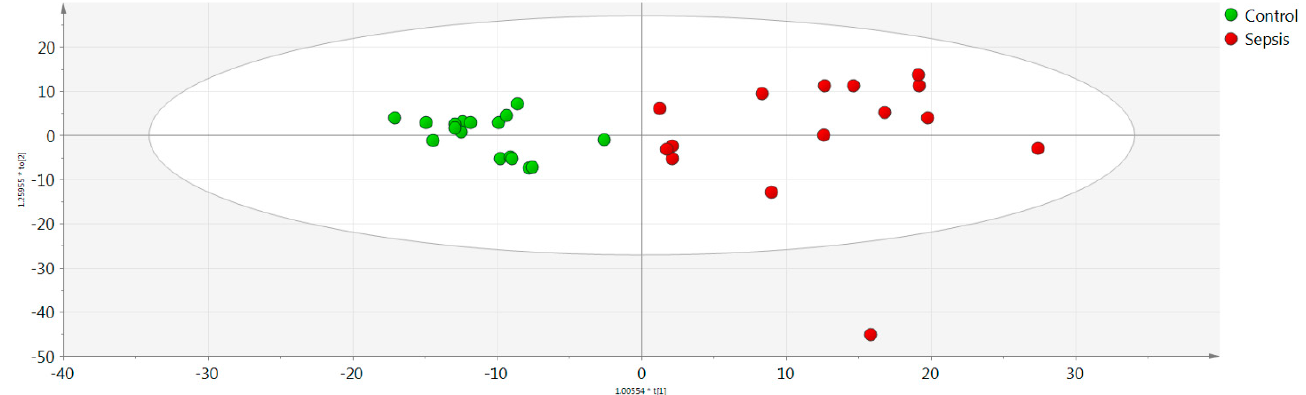
Figure 1. Orthogonal partial least squares discriminant analysis (OPLS-DA) score plot model between the control and late-onset (LOS) groups. Y and X axes represent [t2] and [t1], respectively. Table 1. Statistically significant features with their respective q-value (Bonferroni), p(corr), and VIP values.